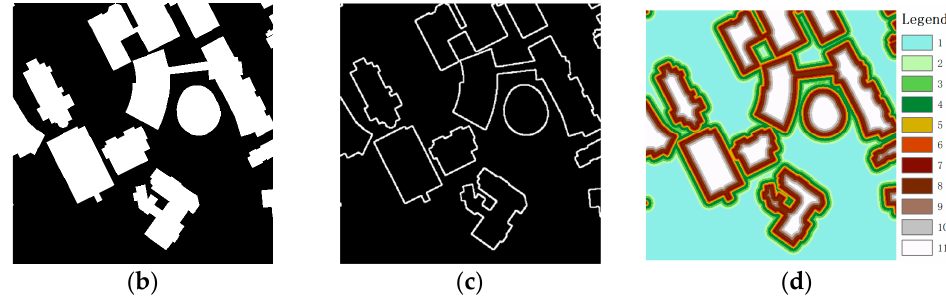
Figure 5. Extracted building representation. ( a ) Original image. ( b ) Building mask. ( c ) Boundary map. ( d ) Distance class map (different numbers stand for different nearest distances from pixels to the boundaries).